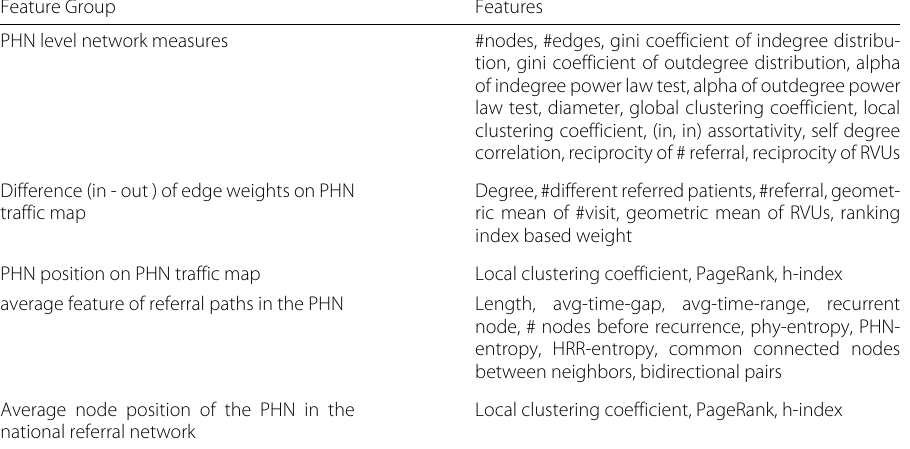
Table 8 The feature list of a hospital (PHN level referral network) for teaching hospital classification Feature